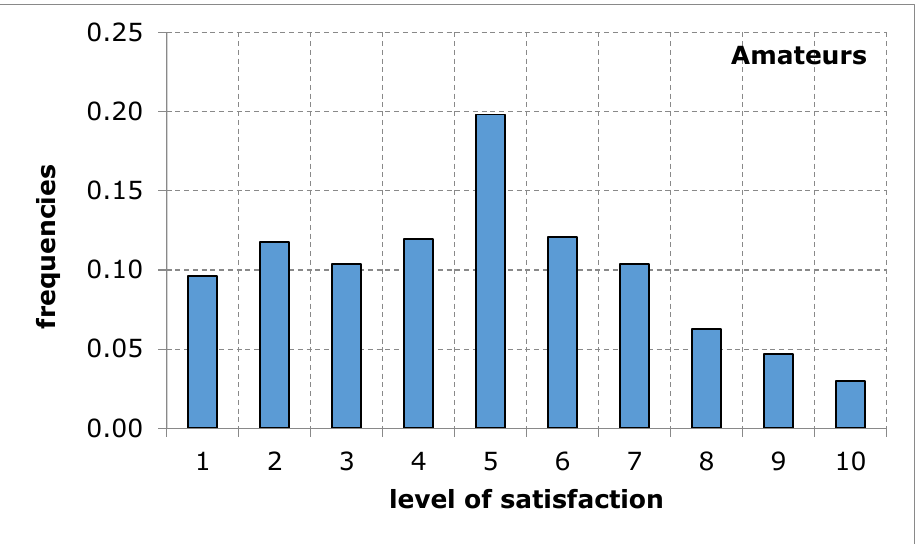
Figure 5. Difficult access to a sports and recreation facility, in the opinion of service recipients (amateurs). Source: own work.